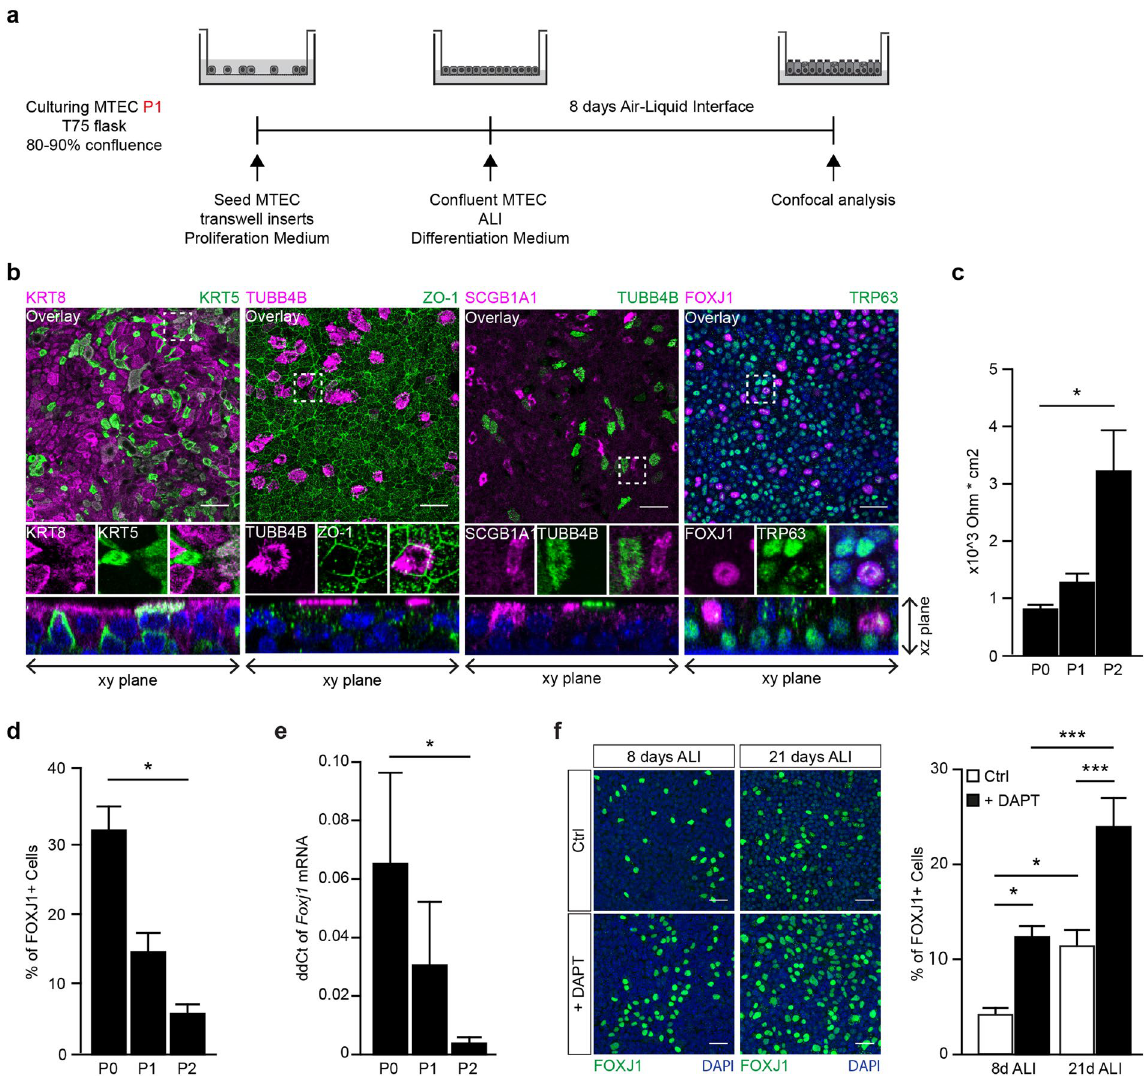
Figure 2. Expansion of MTEC in vitro leads to decreased ciliary and club cell differentiation. ( a ) Schematic representation of culture protocol. ( b ) Co-staining of different epithelial markers on MTEC passage 2 after 8 days of air liquid interface (ALI) culture. From left to right, inserts were stained with basal cell marker KRT5 and luminal marker KRT8, cilia cell TUBB4B with tight junction protein ZO-1, secretory club cell marker SCGB1A1 with cilia marker TUBB4B and the last panel shows TRP63 positive basal cells with ciliated cell marker FOXJ1. Nuclei are stained with DAPI (blue). Scale bar, 30 µ m. ( c ) Resistance measurements of MTEC after different passages and 8 days of ALI (mean ± SEM). * p < 0.05 by one-way ANOVA (n = 3). ( d ) Quantification of the percentage of FOXJ1 positive ciliated cells after 8 days of ALI comparing MTEC in passage (P) 0, 1 and 2 (mean ± SEM). * p < 0.05 by one-way ANOVA (n = 3). ( e ) qRT-PCR analysis of Foxj1 in MTEC in passage (P) 0, 1 and 2 (mean ± SEM). * p < 0.05 by one-way ANOVA (n = 4). ( f ) Representative images and quantification of ciliated cells (FOXJ1) after 8 days or 21 days ALI and with or without the presence of DAPT during differentiation (mean ± SEM). * p < 0.05, *** p < 0.001 by two-way ANOVA (n = 6). Scale bar, 30 µ